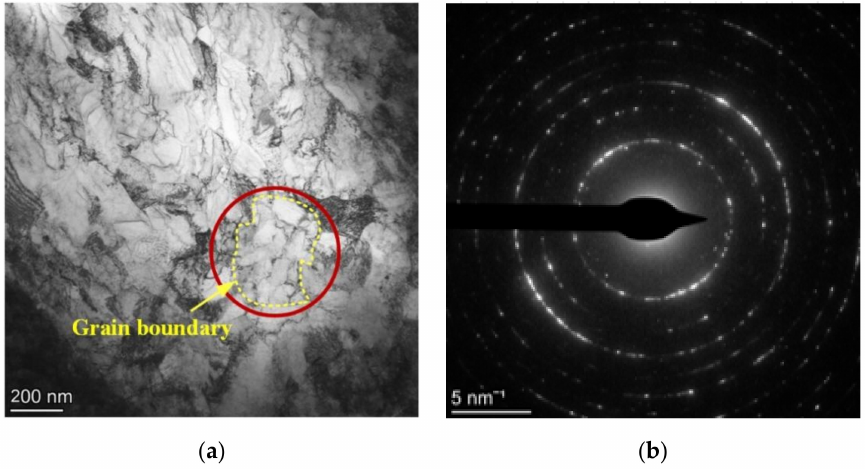
Figure 12. ( a ) TEM morphology and ( b ) selected-area electron diffraction pattern of the cladding layer surface of an E690 high-strength steel sample after